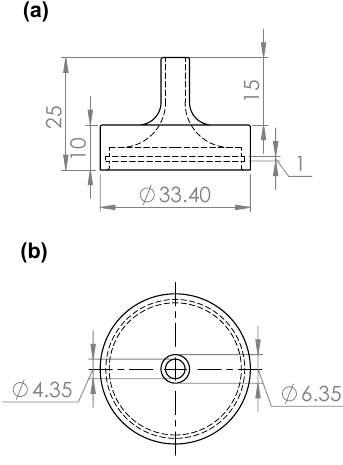
Figure 2. Dimensioned drawing of a single port outlet lid: (a) side view; (b) top view. All dimensions are in millimeters.